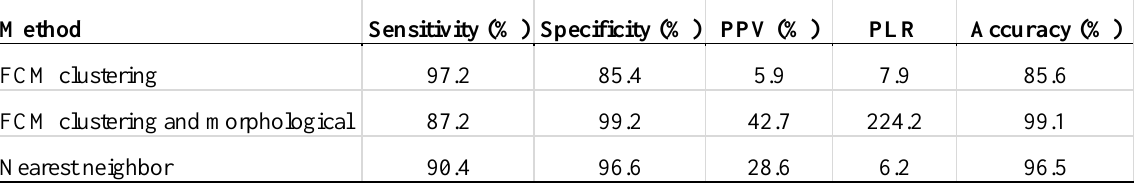
Table 2. Comparison of average result from FCM clustering only, FCM clustering followed by morphological reconstruction and nearest neighbor